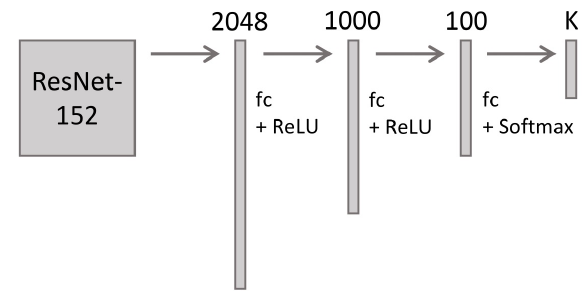
Figure 1. Network architecture for single-task learning. fc: fully connected layers. ReLU: rectified linear unit. K is the number of classes.